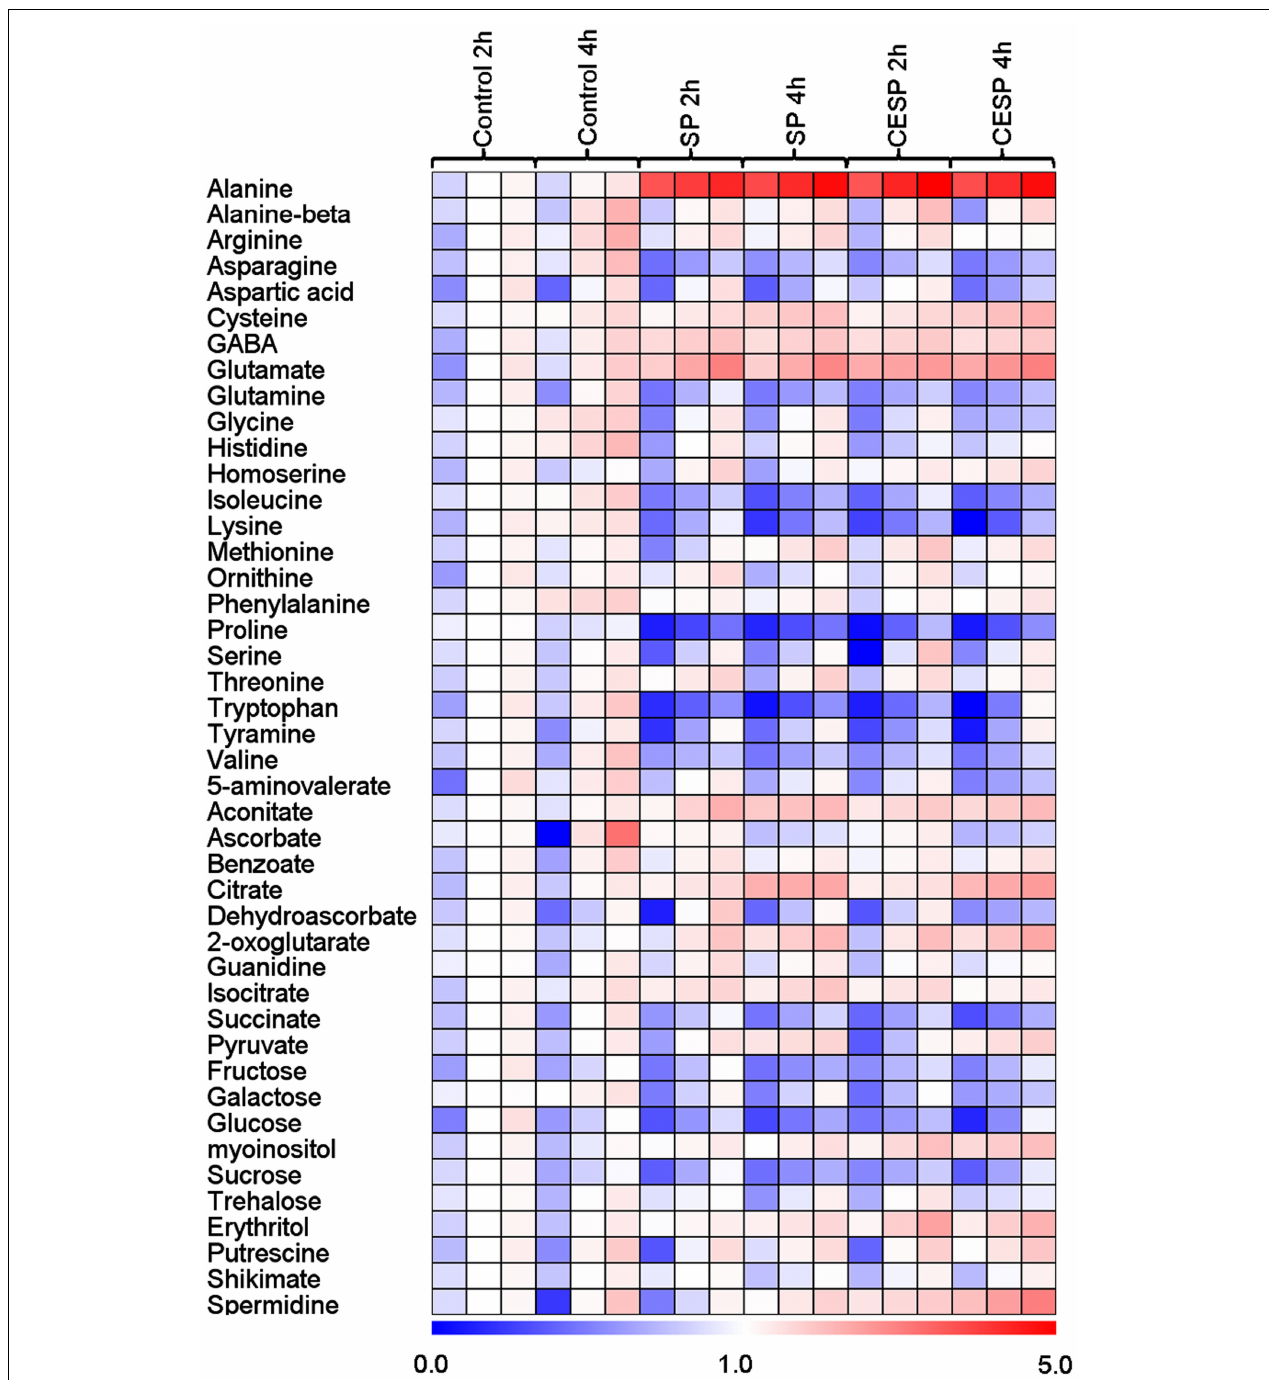
Methods.” Data are normalized with respect to the mean response calculated for the control at 2h.The full data sets from these metabolic profiling studies are available as TableA1 in Appendix including statistical treatment. Green and red represent a decrease and an increase of metabolite content, respectively, in the SP-treated samples with respect to the control samples. The color scale used is reproduced in the